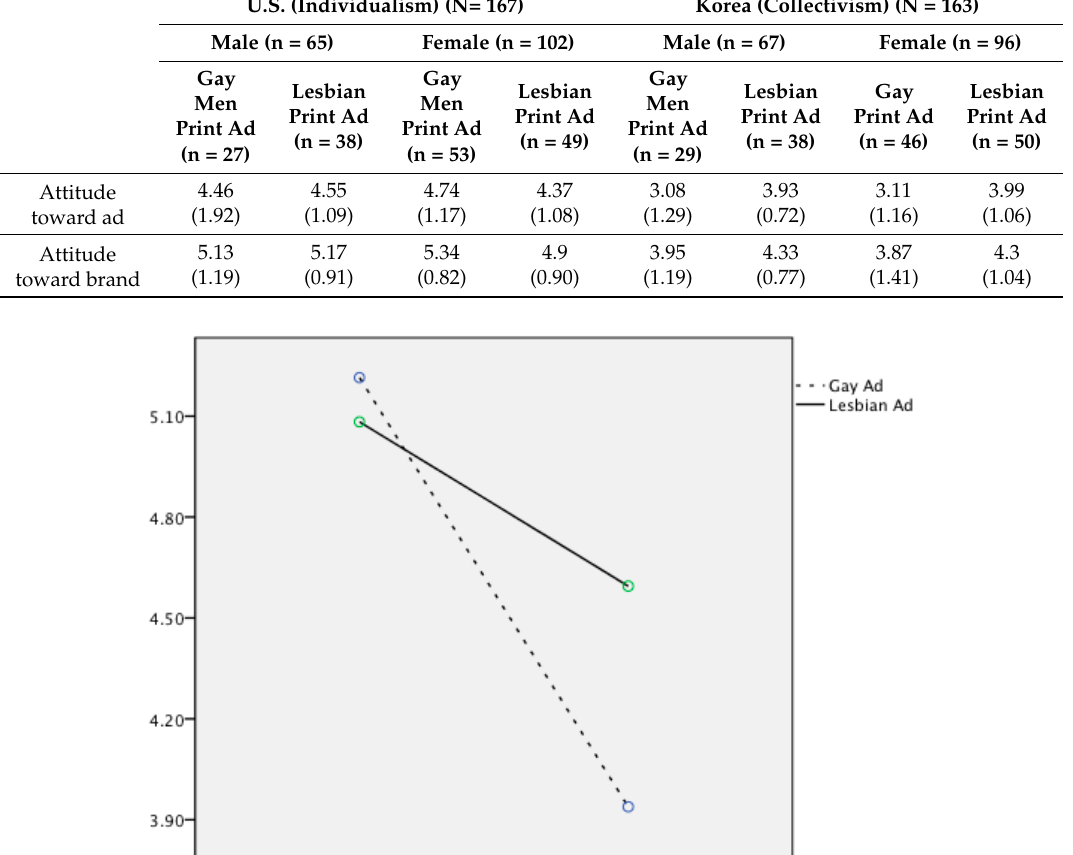
Figure 2. Interaction between cultural orientation and ad type on brand evaluation.